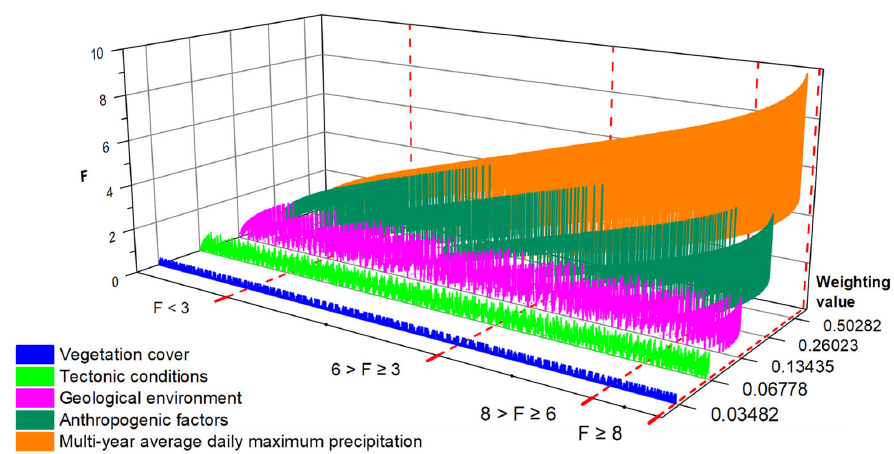
Figure 5. Comprehensive evaluation model of mine debris fl ow distribution area.